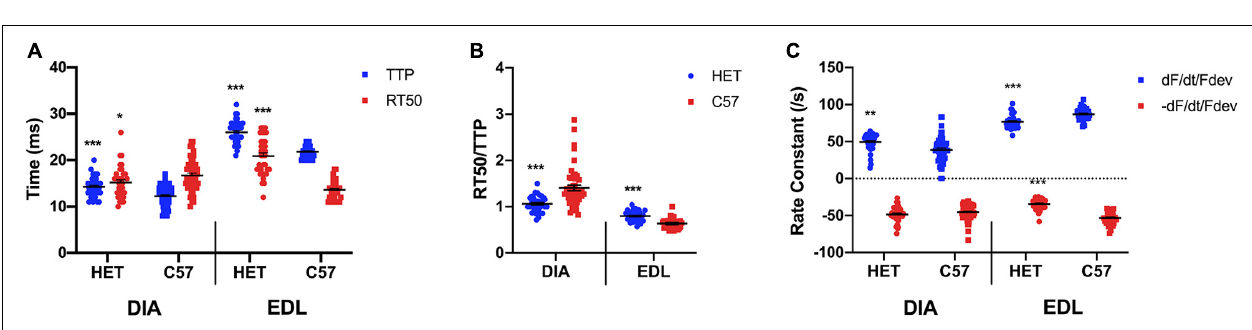
FIGURE 1 | (A) Time to peak and 50% relaxation of 10 week old dystrophic and wildtype muscle types. Kinetic analysis was conducted in diaphragm and EDL muscles from the same mice. Mouse models include dystrophic HET and wildtype C57BL/10. Statistical analysis was conducted using a two-sided t -test. *** indicates P < 0.001 compared to C57BL/10 mice. The line represents the group mean; error bars are standard error of mean. (B) Ratio of time to 50% relaxation and time to peak (RT50/TTP). Mouse models include dystrophic HET and wildtype C57BL/10. Statistical analysis was conducted using a two-sided t -test.*** indicates P < 0.001 compared to C57BL/10 mice. The line represents the group mean; error bars are standard error of mean. (C) Rate constants of individual diaphragm and EDL twitches. Mouse models include dystrophic HET and wildtype C57BL/10. Statistical analysis was conducted using a two-sided t -test. ** indicates P < 0.01, *** indicates P < 0.001 compared to C57BL/10 mice. The line represents the group mean; error bars are standard error of mean.